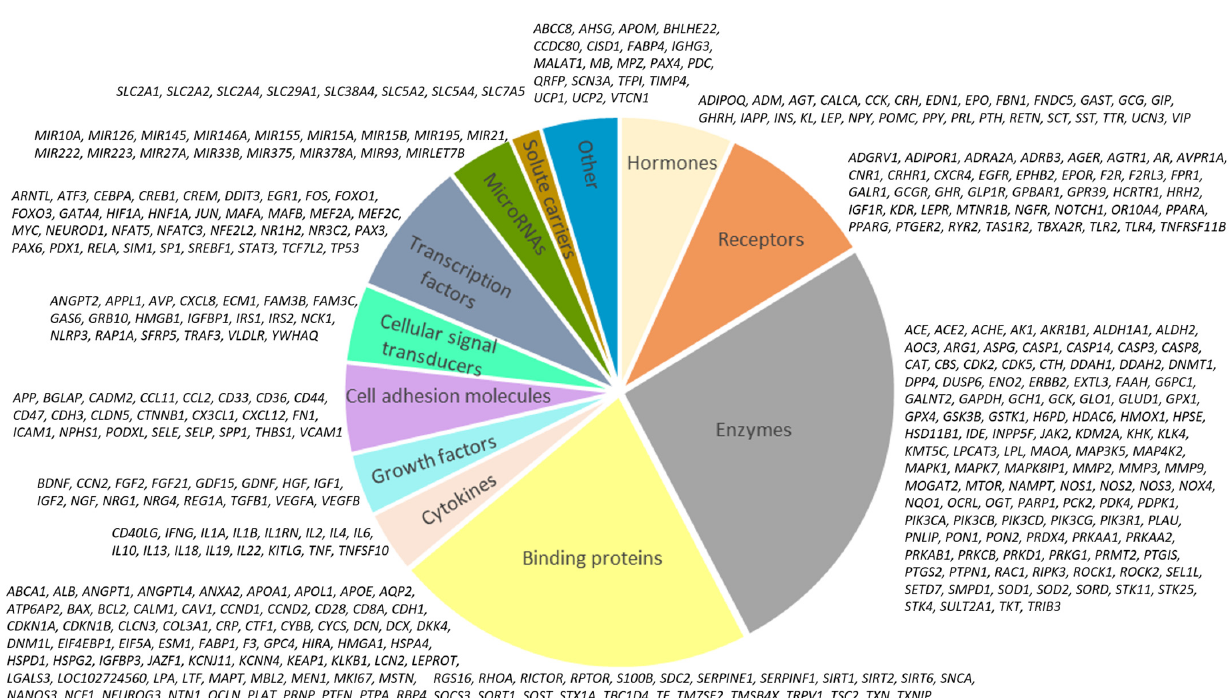
Figure 1. Molecular network associated with hyperglycemia.